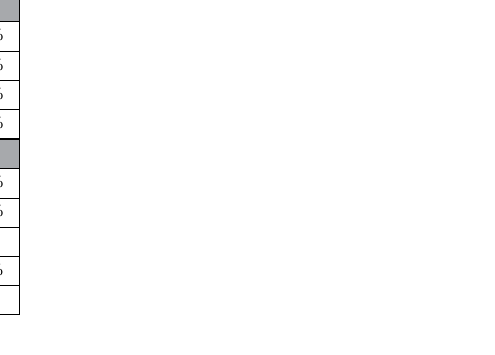
Table 1. Respondents’ sociodemographic